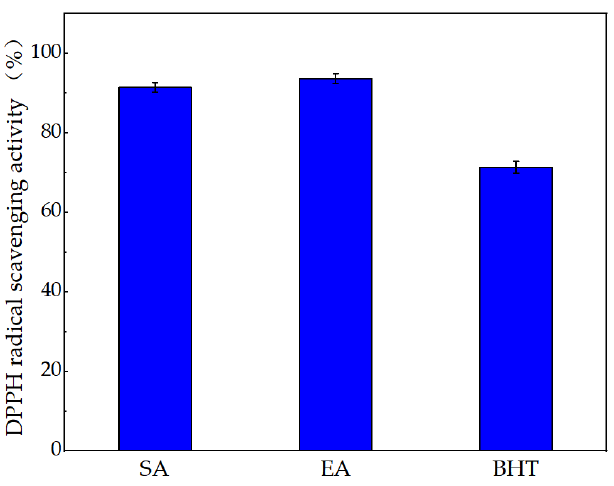
Figure 6. DPPH radical scavenging rates of syringic acid (SA), erucic acid (EA), and BHT.